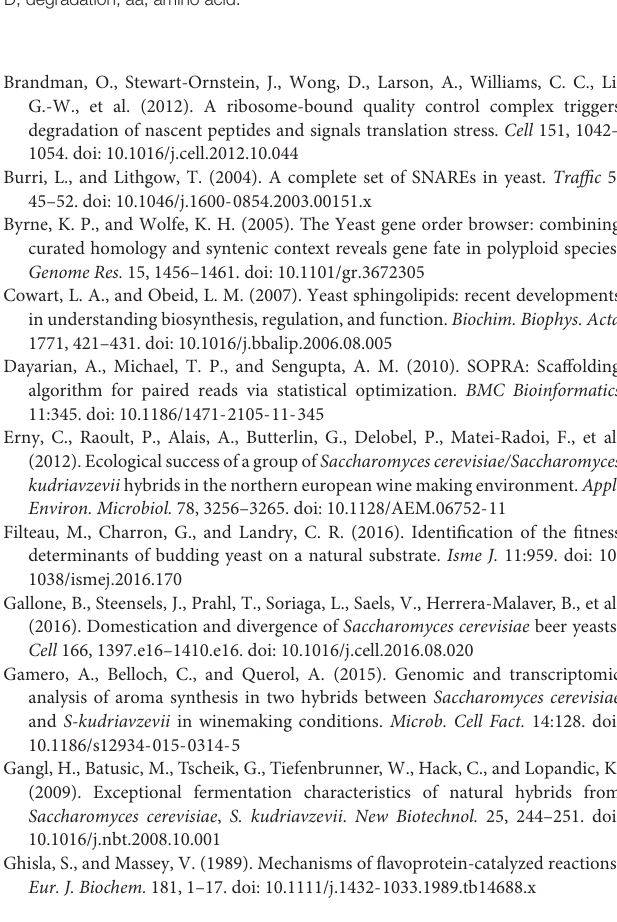
TABLE S1 | Assembly statistics for Sk CA111 and CR85 genome assemblies. TABLE S2 | Positive selection, evolutionary rate test and functional divergence results for all genes analyzed in both Sk and Sc species. PS, positive selection;